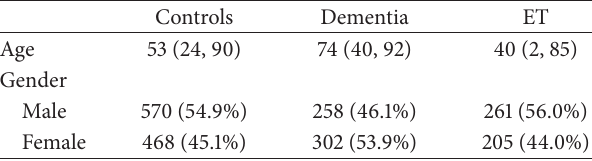
Table 1: Demographics of dementia, ET, and controls.